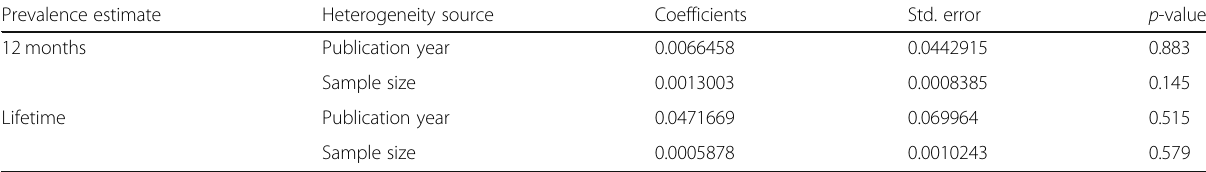
Table 3 A meta-regression analysis of factors for heterogeneity of the prevalence of needlestick injury among the healthcare workers in Ethiopia,